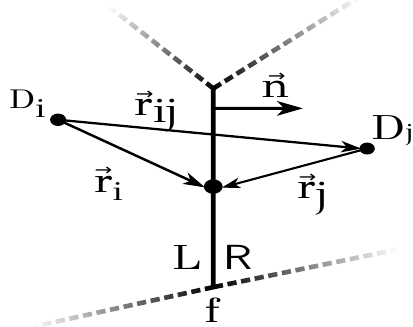
Figure 1. Reconstruction of variables on face f